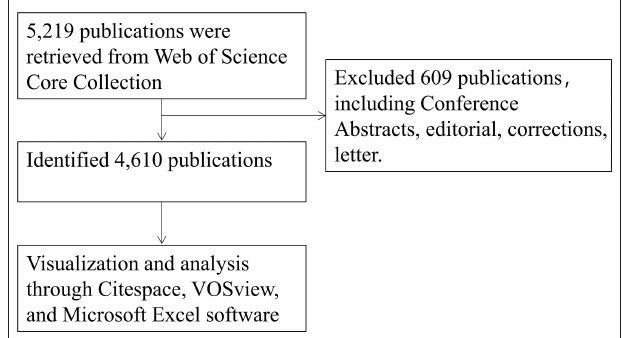
FIGURE 1 | A flowchart of the publication screening